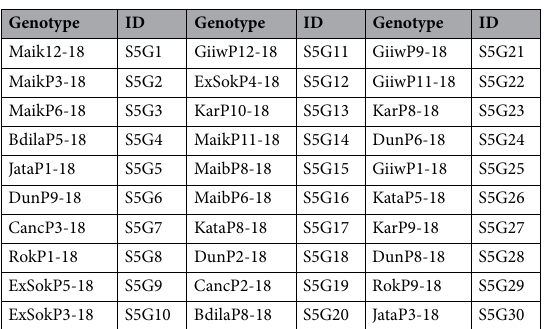
Table 1. The list of thirty selected Bambara groundnut accession used in this study. The 11 accessions were: Maik Maikai, Bdila Bidillali, Jata Jatau, Dun Duna, Canc Cancaraki, Rok Roko, ExSok Exsokoto, Giiw Giiwa, Kar Karu, Maib Maibergo, Kata Katawa.